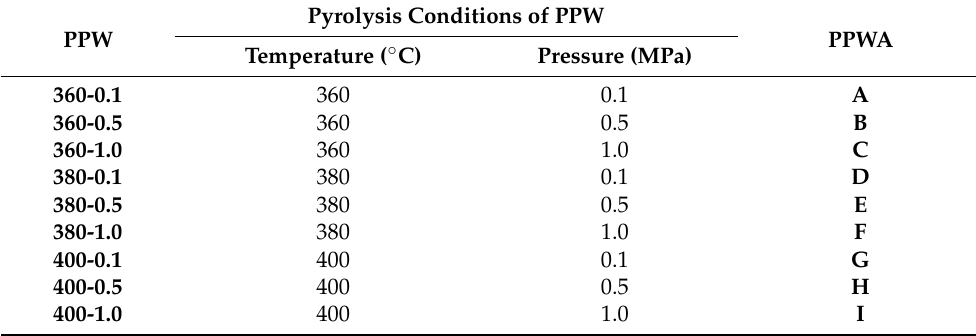
Table 1. Synthetic conditions of PPW and the corresponding PPWA.